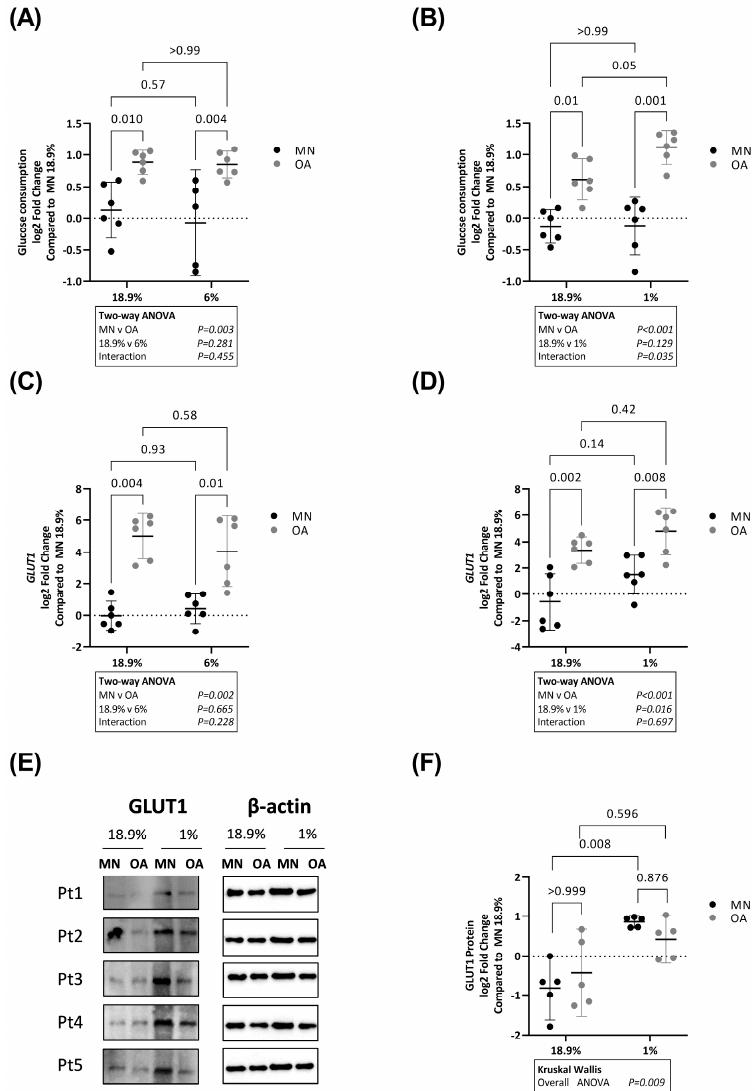
Figure 4. Glucose consumption and GLUT1 glucose transporter levels in OA chondrocytes and chondrocytes from macroscopically normal cartilage maintained in 18.9% compared to 6% or 1% oxygen. Paired samples of human chondrocytes isolated from macroscopically normal (MN) and osteoarthritic (OA) cartilage regions within OA joints from six patients were plated in duplicate plates. One plate was transferred to a standard tissue culture incubator (18.9% oxygen) and the other transferred to a hypoxia incubator maintained at either 6% or 1% oxygen for 24 h. Chondrocytes from a di ff erent six patients were used to compare the e ff ects of 18.9% vs. 1% oxygen than those used to compare the e ff ects of 18.9% vs. 6% oxygen. Comparison of glucose consumption in ( A ) OA chondrocytes and chondrocytes from MN cartilage maintained in 18.9% vs. 6% oxygen and ( B ) OA chondrocytes and chondrocytes from MN cartilage maintained in 18.9% vs. 1% oxygen. Comparison of RNA levels (measured by qPCR) of ( C ) GLUT1 in cells maintained in 18.9% vs. 6% oxygen and ( D ) GLUT1 in cells maintained in 18.9% vs. 1% oxygen. ( E ) Western blots showing GLUT1 protein levels and ( F ) quanti fi cation of GLUT1 protein expression using band densitometry in OA chondro- cytes and chondrocytes from MN cartilage maintained in 18.9% vs. 1% oxygen ( n = 5). Pt = patient. Data shown are mean ± 95% CI. GLUT1 Western blot data were analysed by Kruskal–Wallis test. All other data were analysed by two-way ANOVA. Statistically signi fi cant di ff erences between groups following post hoc testing are shown on graphs. p < 0.05 was considered statistically signi fi cant.